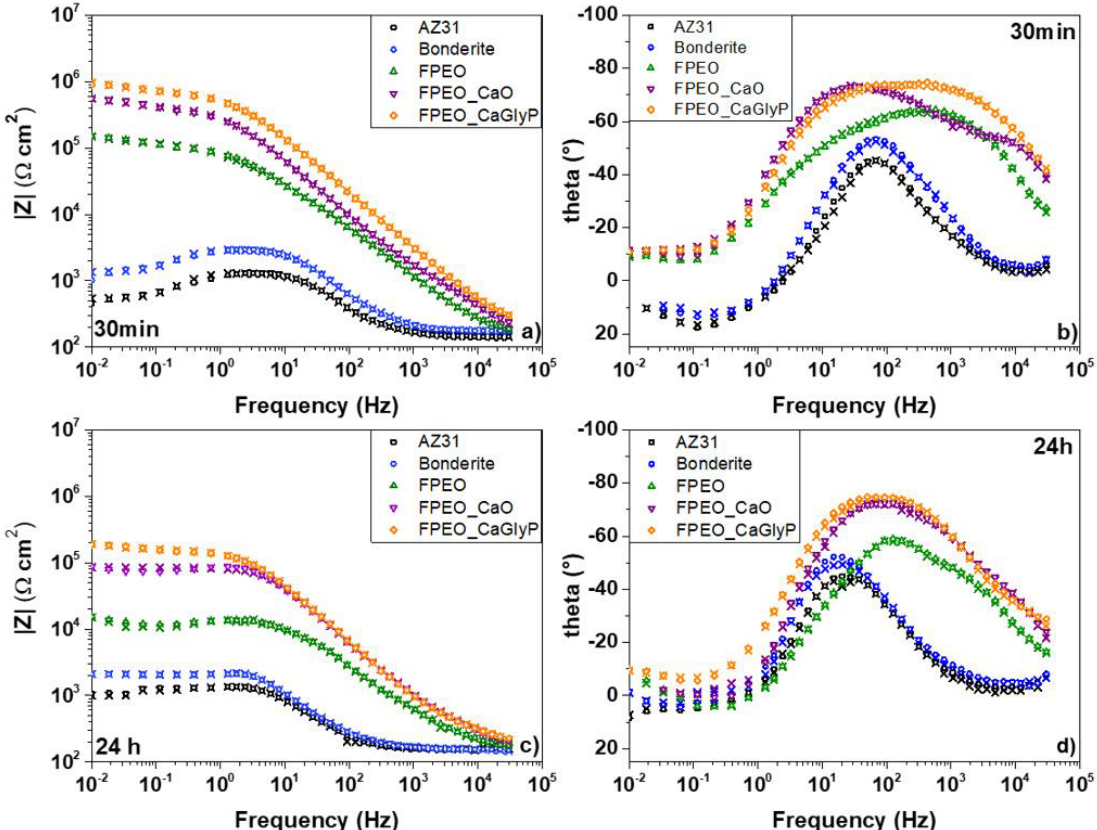
Figure 8. Bode plots of the EIS spectra for non-painted materials following 30 min ( a , b ) and 24 h ( c , d ) immersion in 0.5% NaCl. Empty symbols correspond to the experimental data, cross symbols correspond to the fitting.